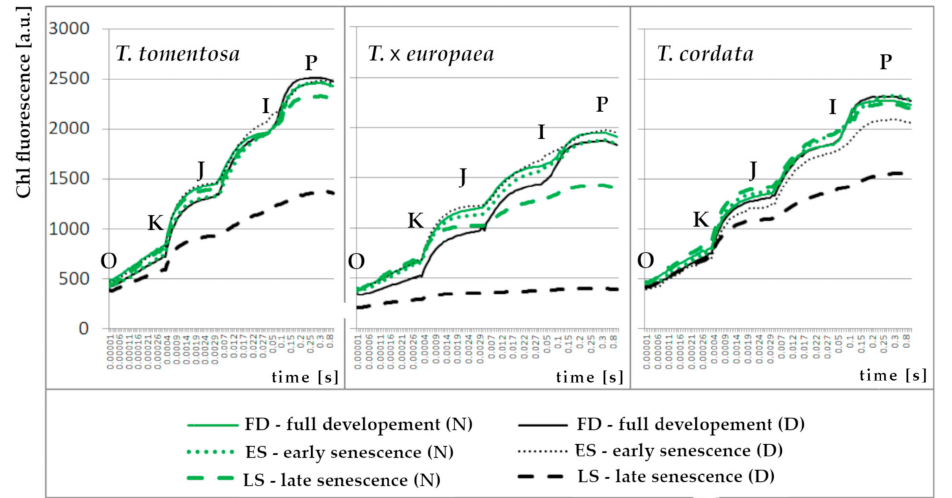
Figure 3. OJIP chlorophyll a fluorescence transient (O–0.00005 s, K–0.003 s, J–0.002 s, I–0.03 s, and P = Fm) for investigated Tilia species measured for fully developed leaves, early and late senescence in seasons with a deficit of precipitation (D) and normal (N)